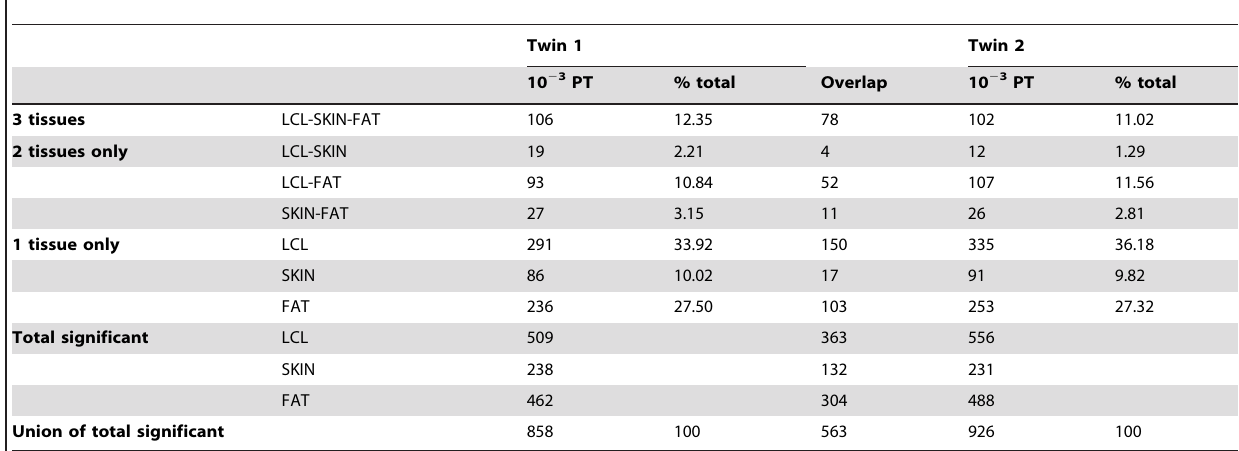
Table 2. Tissue-shared and tissue-specific gene associations (10 2 3 PT), SRC